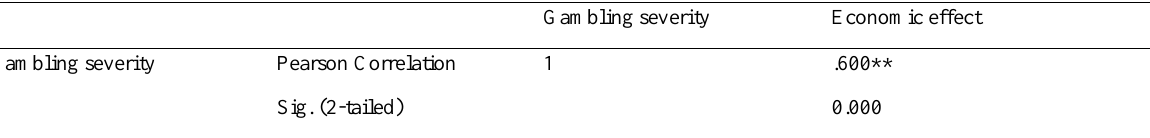
Table 5: Correlation between Gambling Severity and economic